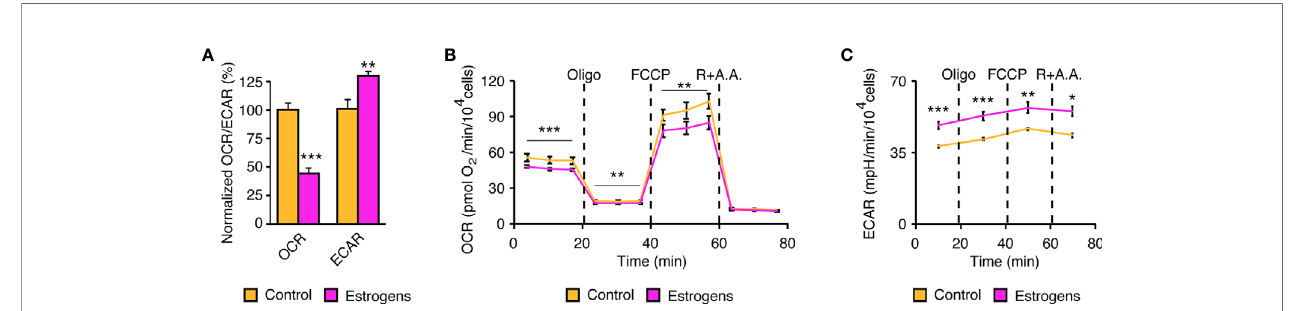
FIGURE 5 | Reprogramming of mammary epithelial cell metabolism in two-dimensions by estrogens. (A) Extracellular fl ux analysis of mammary epithelial cells using an XFe96 Seahorse apparatus. Oxygen consumption rate (OCR), an indicator of mitochondrial respiration, and the extracellular acidi fi cation rate (ECAR), an indicator of aerobic glycolysis, are shown normalized to their respective controls. (n= 3 biologically independent samples). Metabolic fl exibility of OCR (B) and ECAR (C) after injections of mitochondrial modulators. Dashed lines indicate when in the assay the different drugs were injected and followed by the metabolic response. Oligo, oligomycin; R, rotenone; AA, antimycin. (A) Results are shown as the mean ± SEM of one out of four independent experiments, each with 4-5 biological replicates per group. All experiments were performed in primary mammary epithelial cells in two-dimensions after 3 days in culture and 48 h of treatment with estradiol or